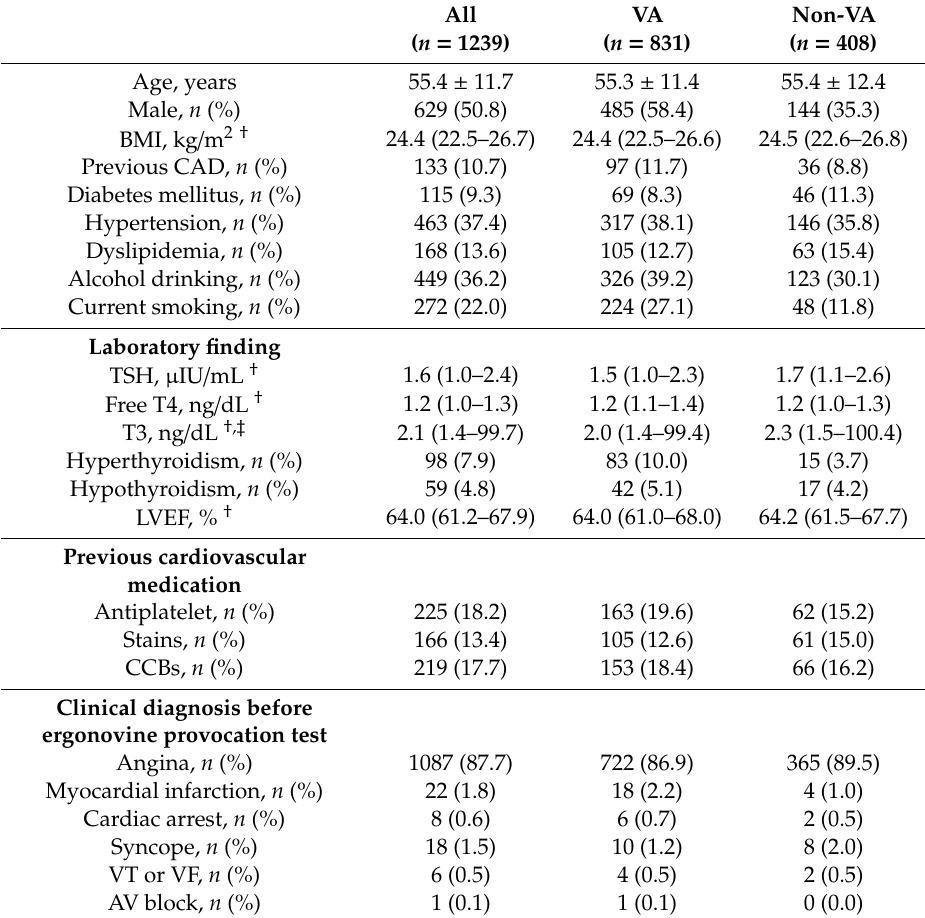
Table 1. Baseline